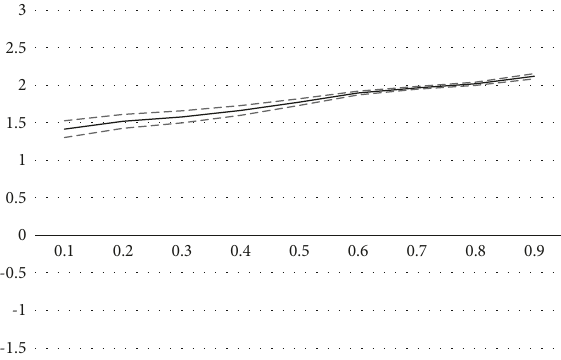
Figure 5: Region-EPU quantile regression